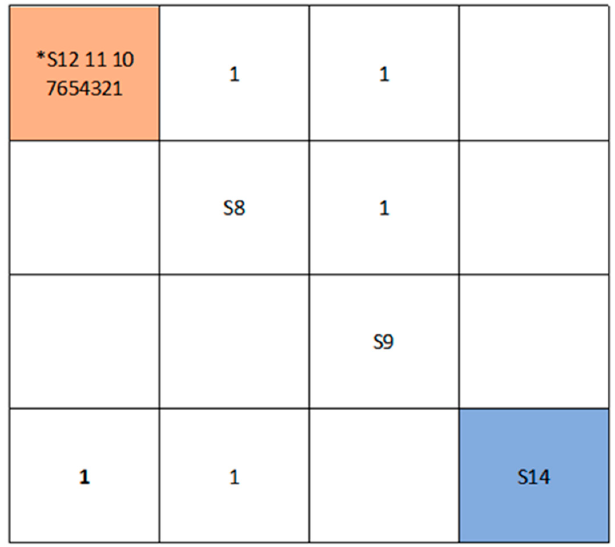
Figure 5. Results of the N2 method (orange colour for critical elements in the decision-making, i.e., Institutional group and Adoption and Maintenance group, and blue colour for source, i.e., users). S8 and S9 correspond to consultancies that do the designs and the contractors that do the construction. Stakeholder numbers (S1–14) correspond to those defined in Table S2.